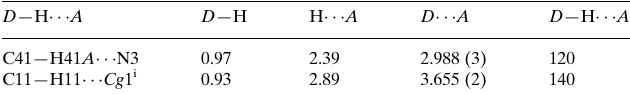
Hydrogen-bond geometry (A˚ , (cid:2) ). Cg 1 is the centroid of the C14–C19